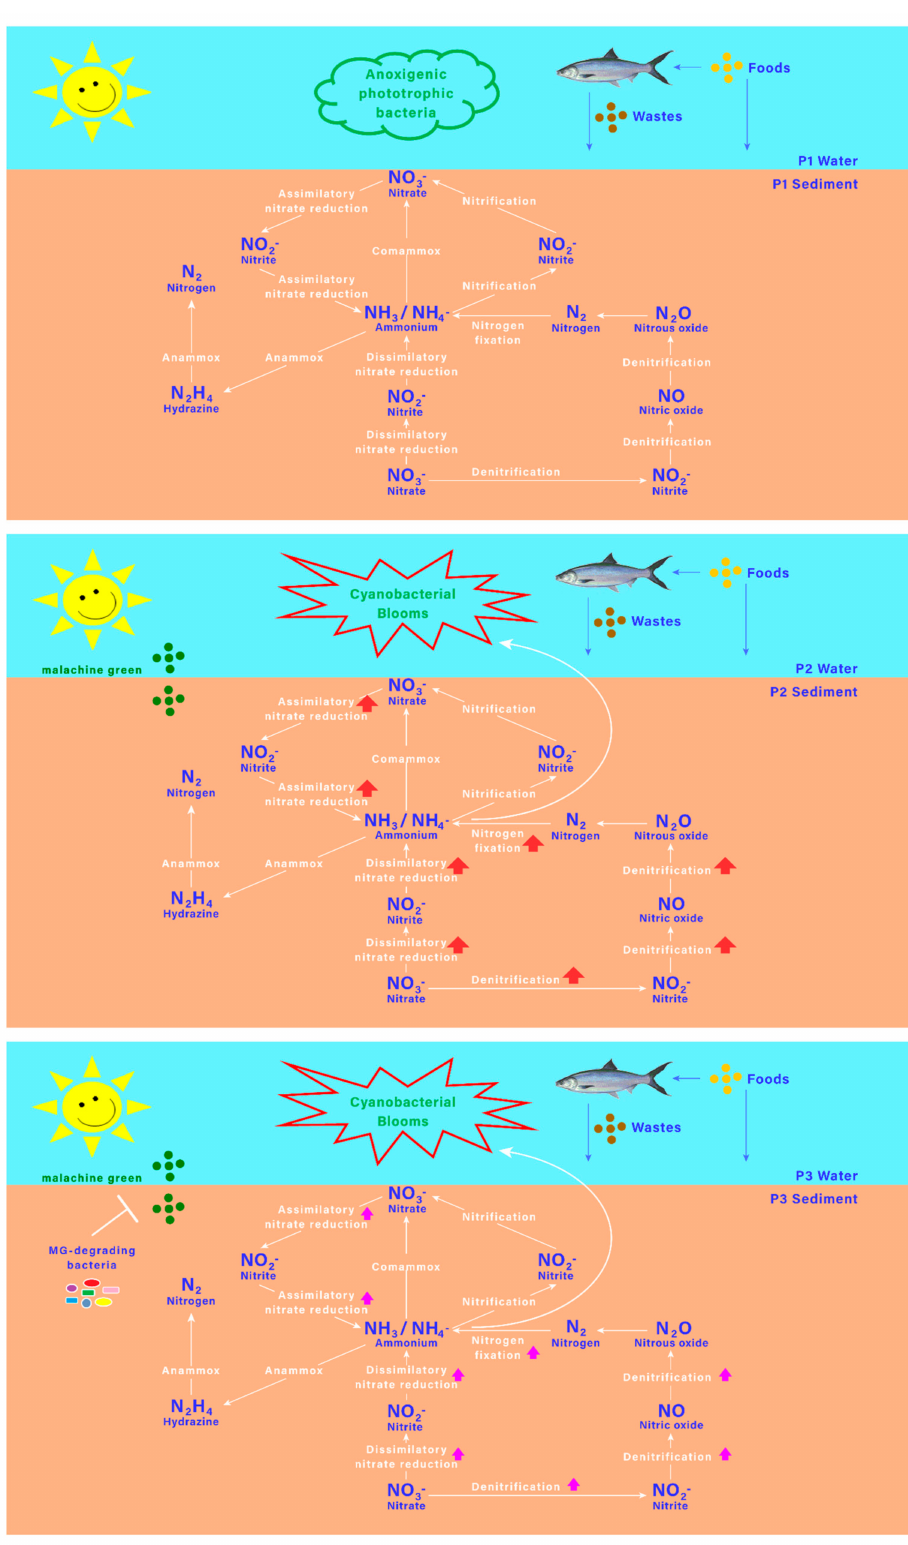
Figure 8. Summary of effects of malachite green on nitrogen cycle-associated microbial communities among the water and sediment of small milkfish ponds. P1: control small milkfish pond. P2: small milkfish pond with the addition of MG. P3: small milkfish pond with the addition of MG and MG-degrading